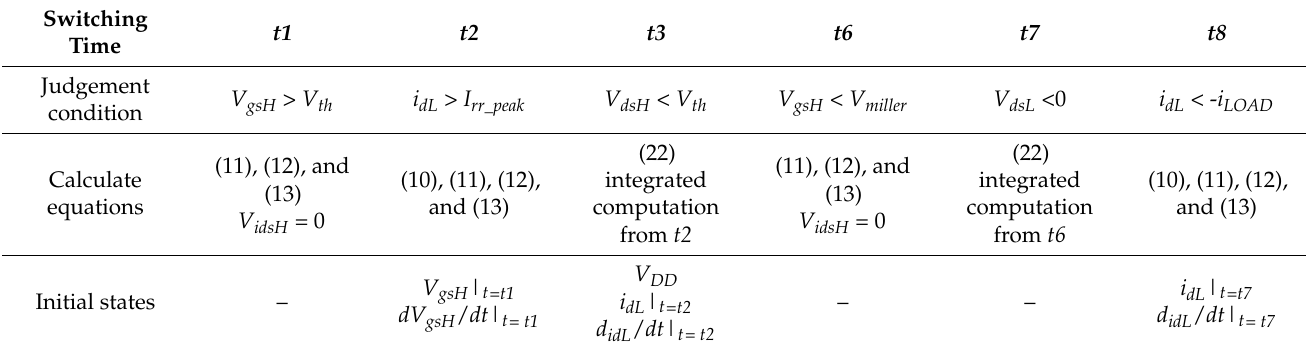
Table 4. Switching Time and Calculations of Judgement